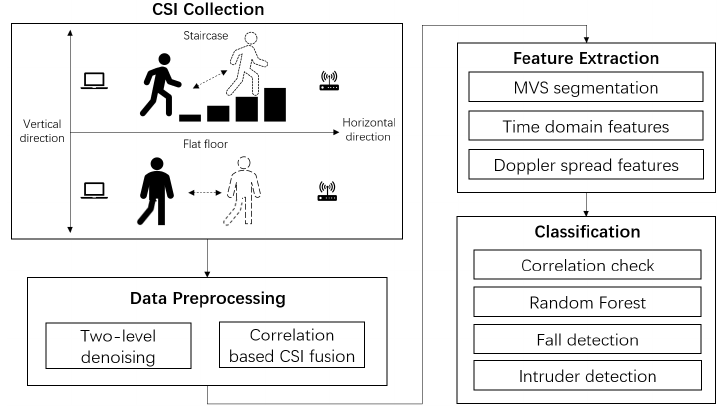
Figure 1. System architecture and data